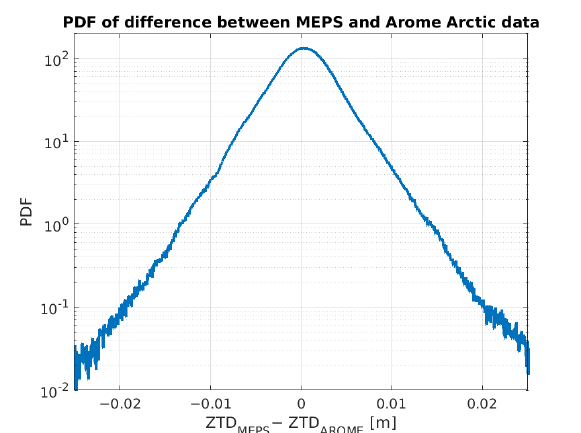
Figure 3. PDF of the difference between calculated ZTD based on MEPS data and on AROME Arctic data.